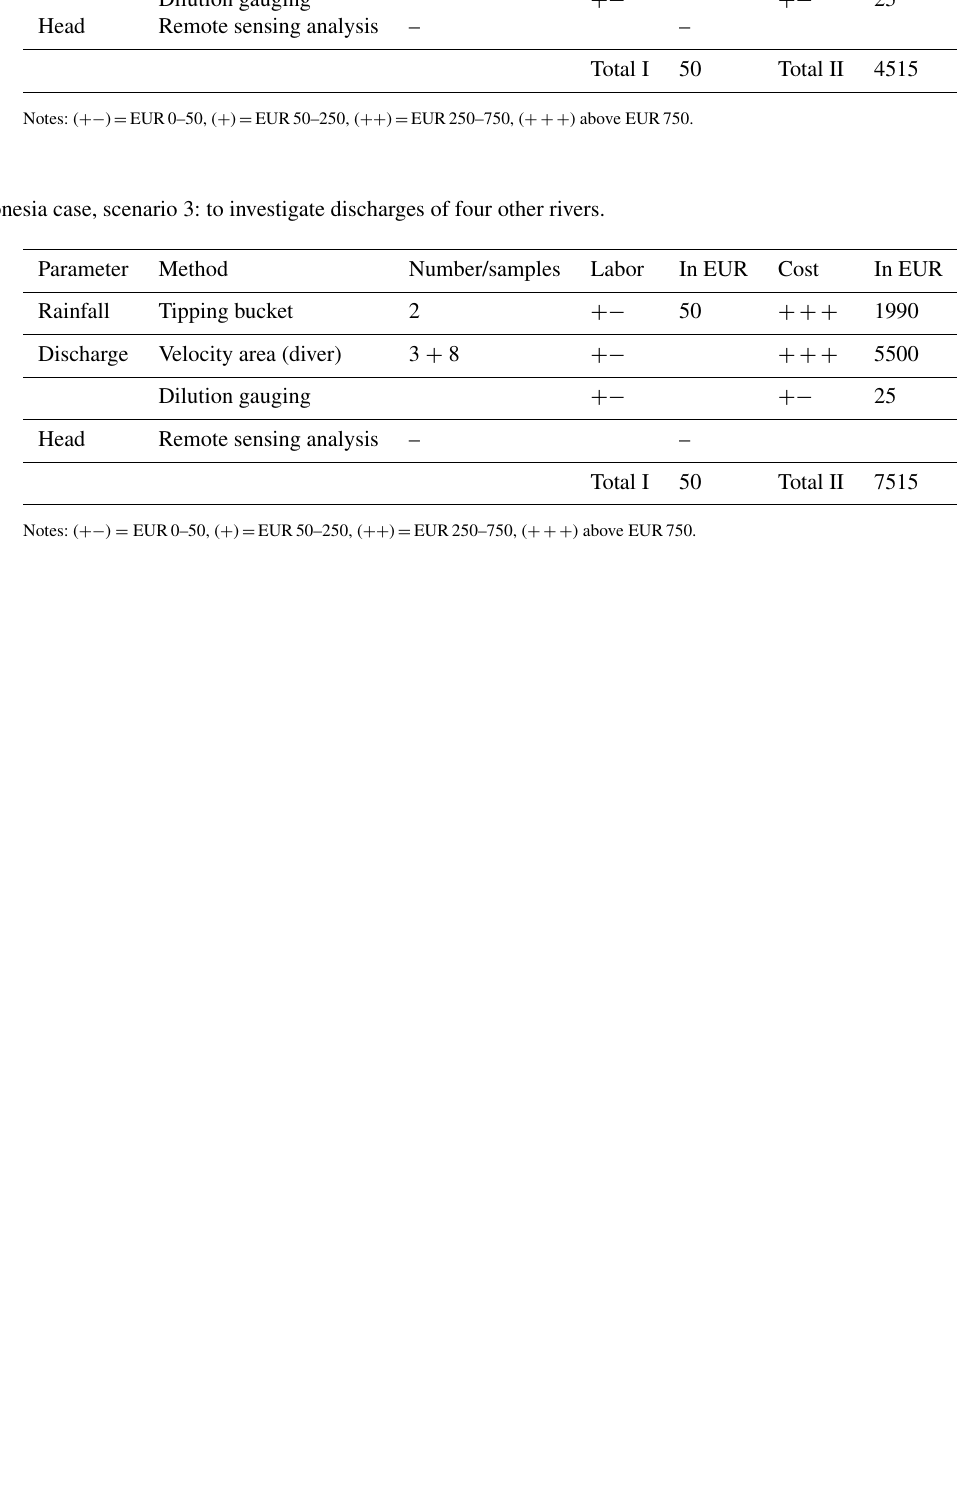
Table A8. Indonesia case, scenario 2: to investigate discharge of another river. Parameter Method Number/samples Labor In EUR Cost In EUR Rainfall Tipping bucket 2 +− +++ 1990 Discharge Head – –